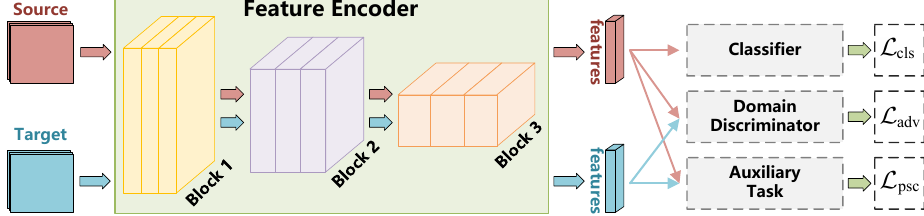
Figure 1. Illustration of the proposed PSCAN. The propagation of the data from different domains is marked by arrows of different